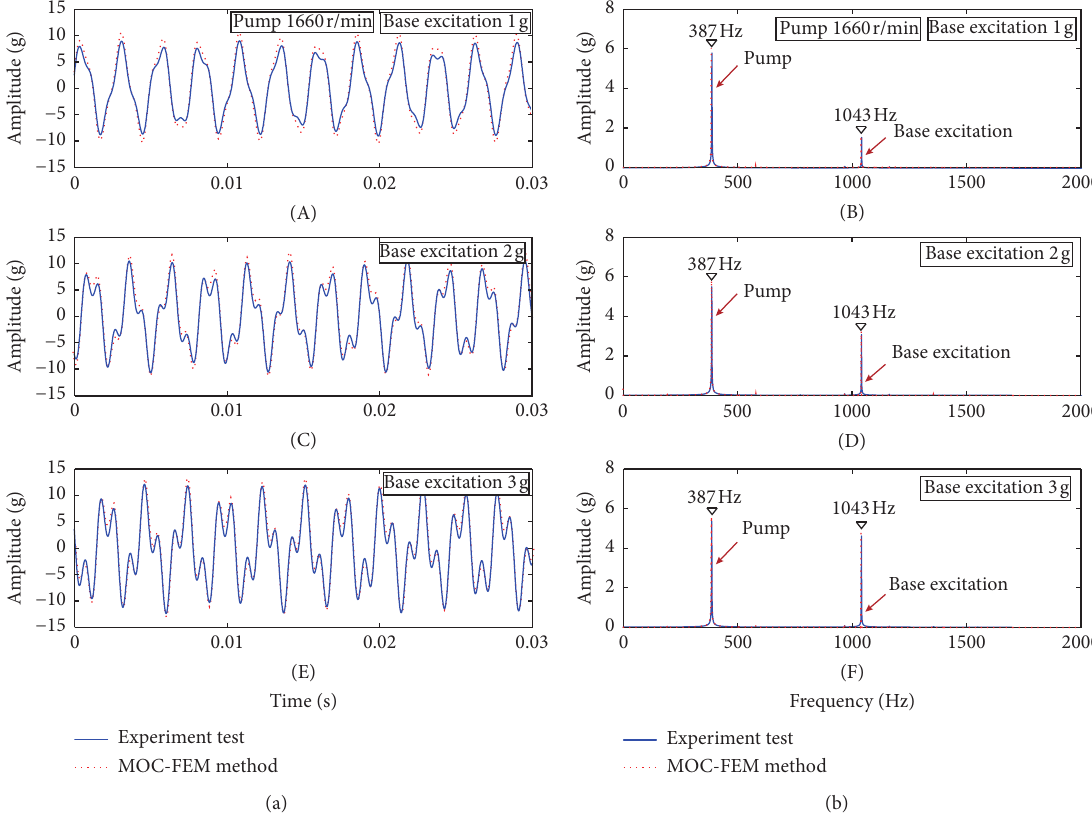
Figure 8: Pipeline vibration response under the superposition of fluid pressure pulsation and high-order base harmonic excitation. (a) Vibration response for time domain and (b) pipeline frequency spectrum.